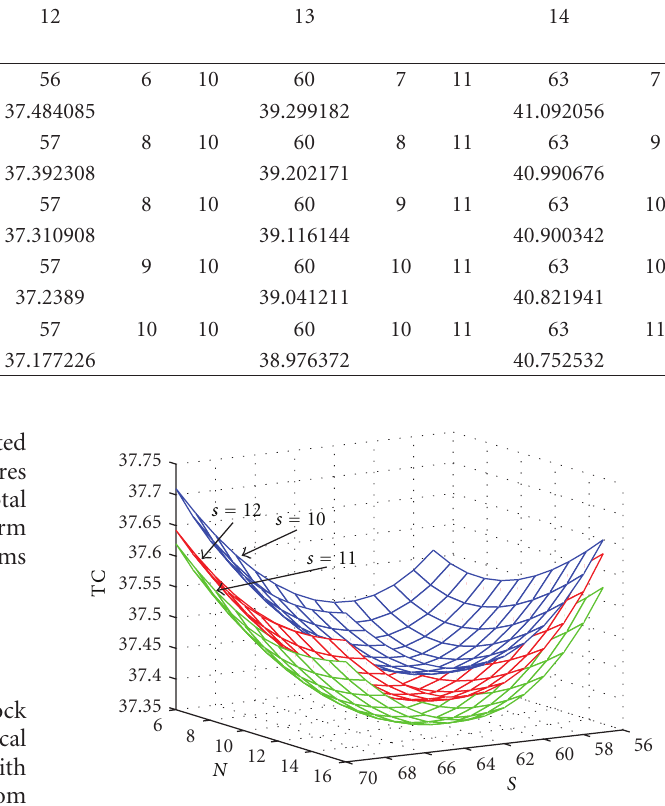
Figure 1: A three-dimensional plot of the cost function. λ = 14, i ∗ α , i = 1,2, ... , N , α = 4, μ = 4, γ = 1 . 2, β = 1 . 3, α i = . 3, c c p = 0 . 85, c = 0 . 3, c = 5, c p = h = 0 s = 15, pr sh